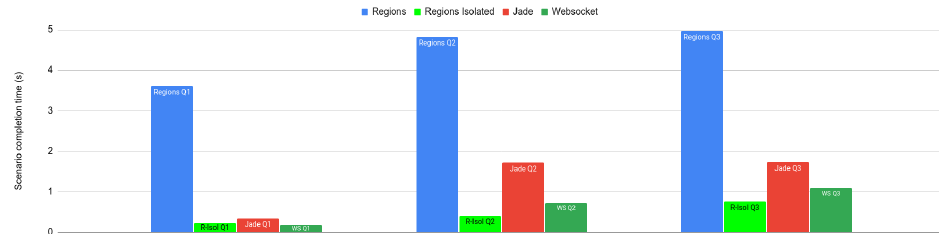
Figure 9. Distribution of scenario completion times (first, second, and third quartiles) for agents in the “intensive communication” scenarios. Regions —agents communicate mostly across regions, using the WS-Regions Protocol; Regions Isolated ( R-Isol )—agents only communicate within the same region, using the WS-Regions Protocol; Jade —agents communicate using Jade; WS —agents communicate using a centralized WebSocket-based